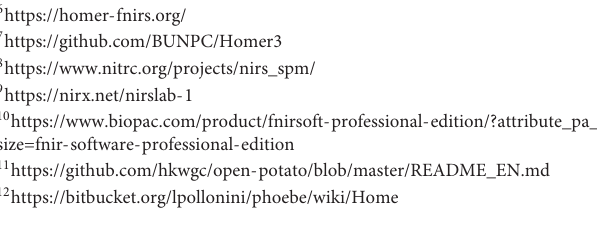
usage of fNIRS-specific data analysis packages (e.g., HOMER2 6 , HOMER3 7 , NIRS SPM 8 , nirsLAB 9 , fNIRSOFT 10 , open-potato 11